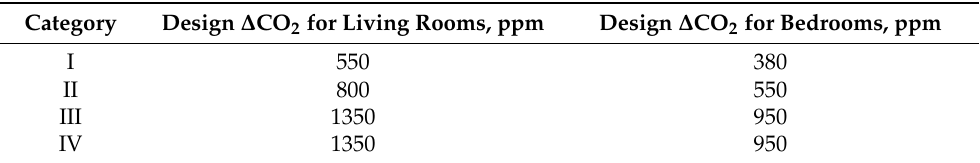
Table 2. Building categories and recommended design of an increase in CO 2 concentration in the room air above the level outside the building